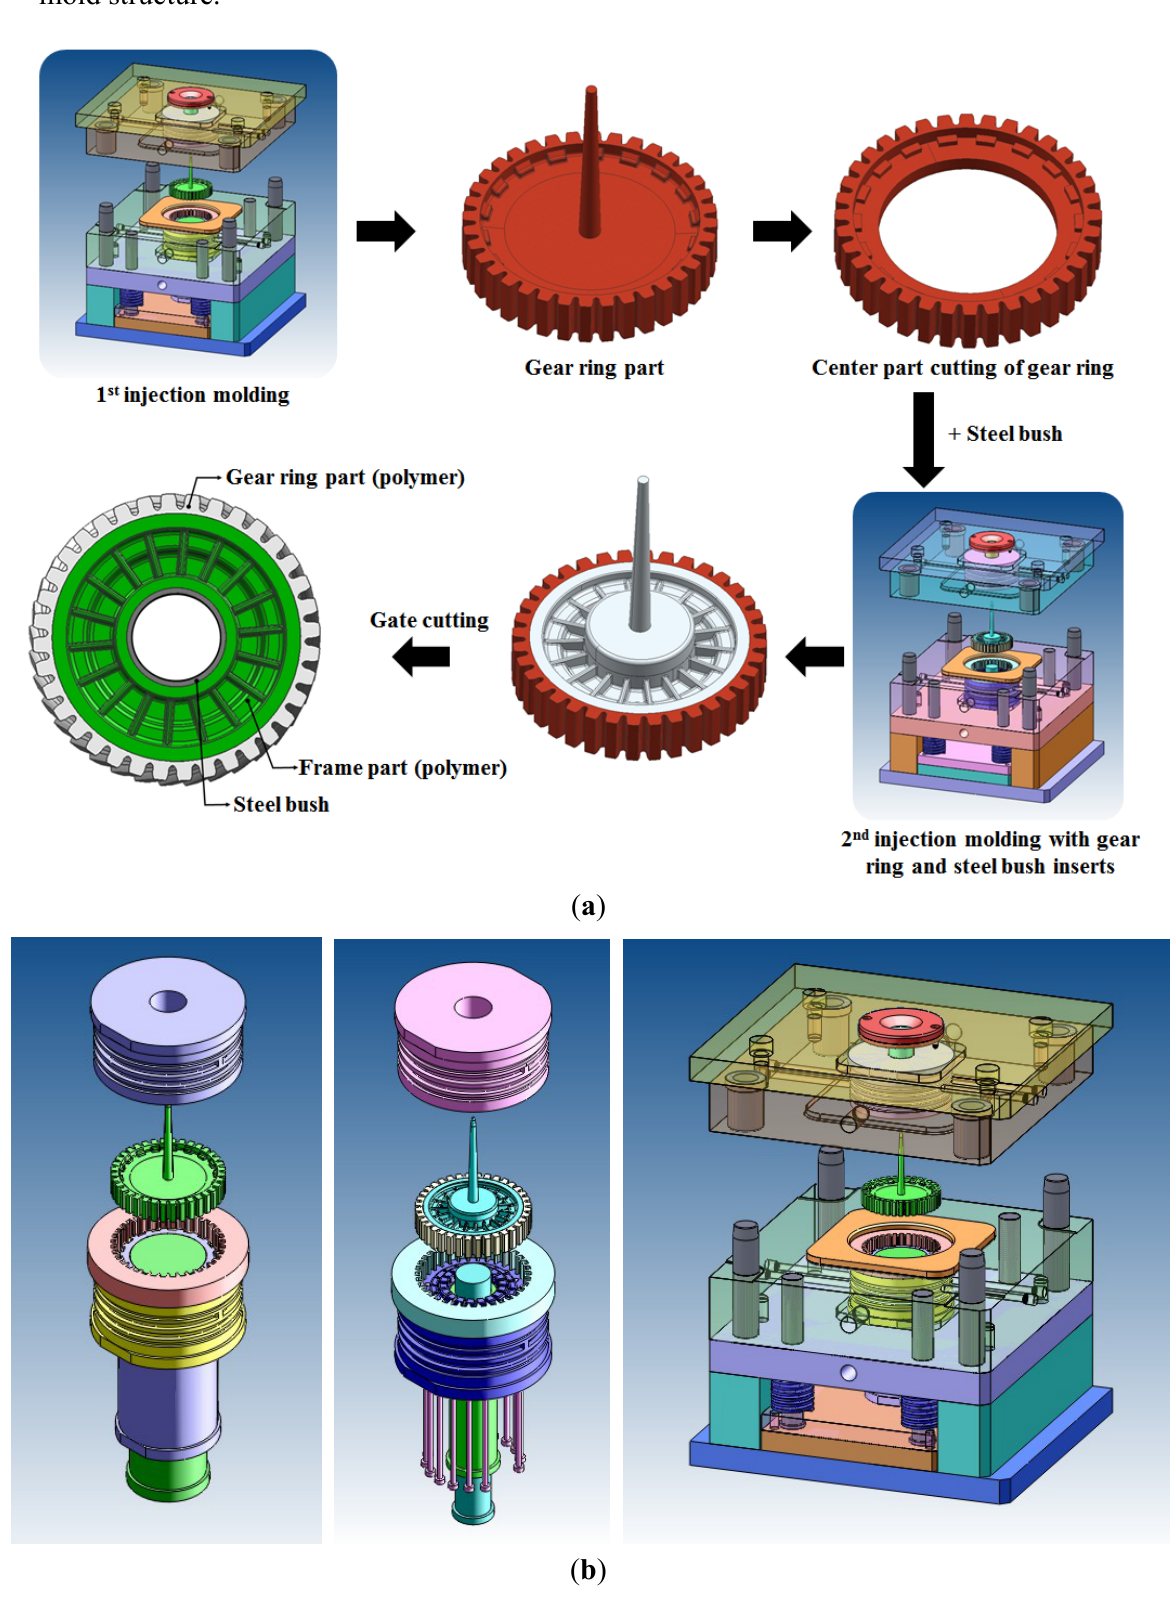
Figure 4. Injection mold components design for plastic worm wheel fabrication ( a ) design of injection molding process for plastic worm wheel; ( b ) design of insert core and mold